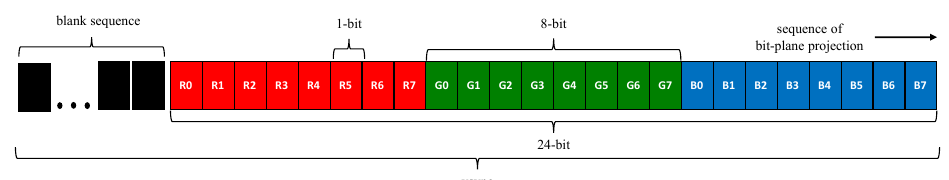
Figure 15. Bit-plane projection pattern for a single RGB image.